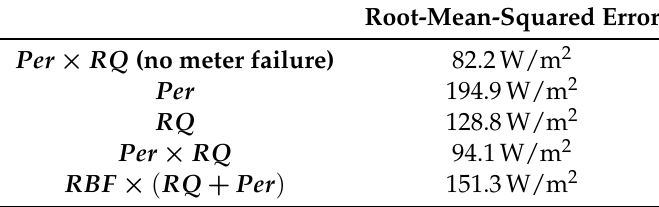
Table 3. The root-mean-square error of Gaussian process regression on one-hourly averaged data for different kernels